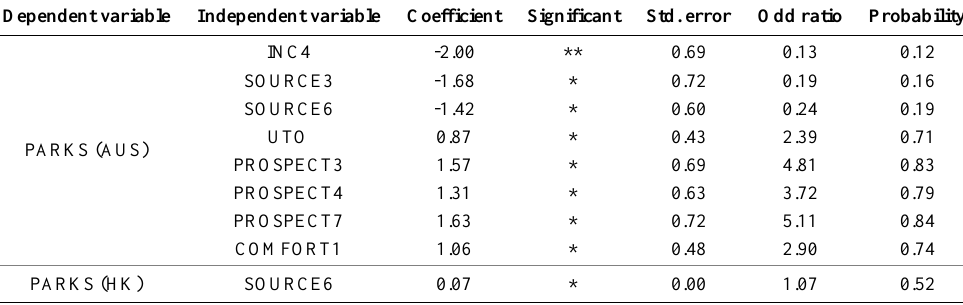
Table A-14. Parks and recreation